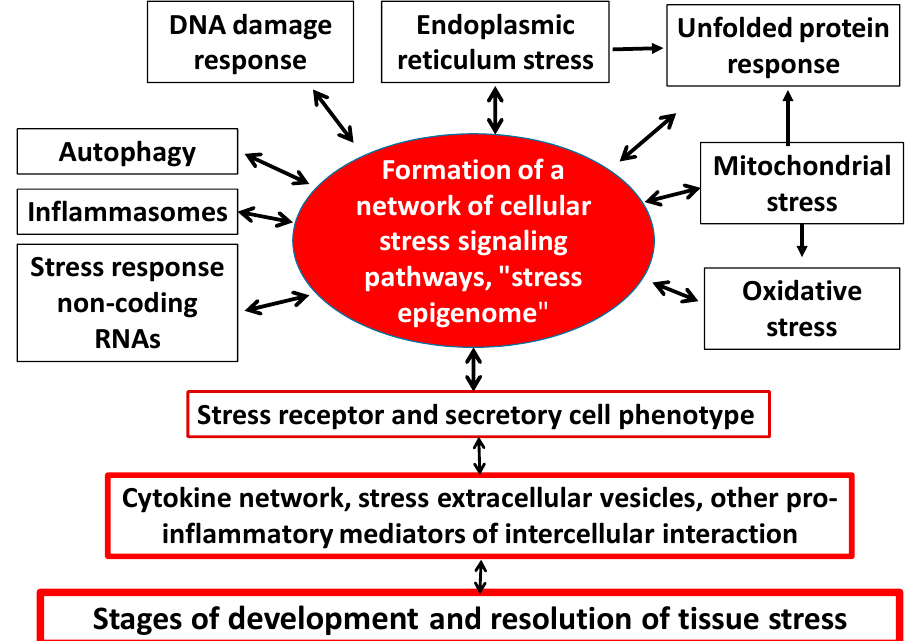
Figure 3. Structure of typical cellular stress processes and its relationship with tissue stress.